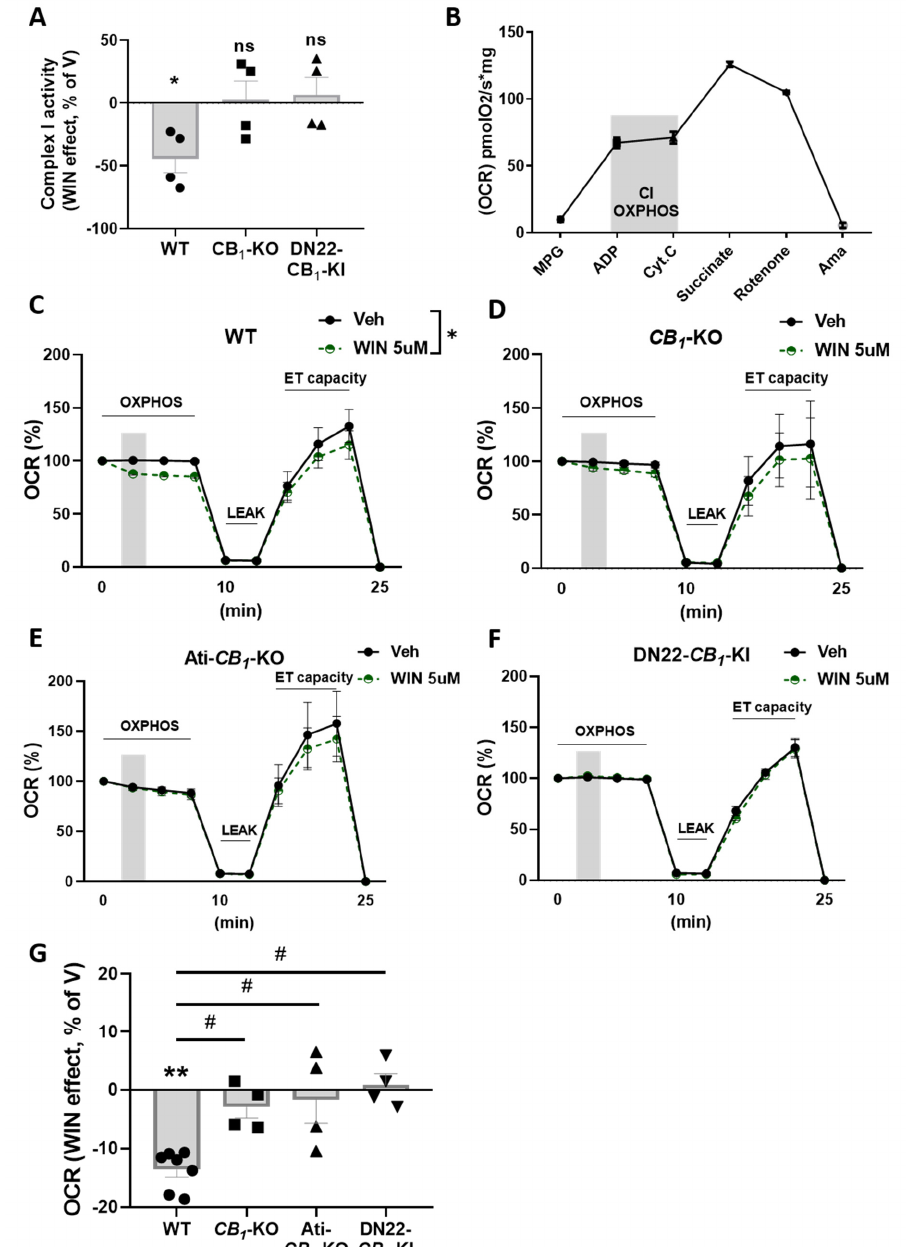
Figure 2. Mitochondrial effects of CB 1 activation in eWAT. ( A ) WIN 5 µ M effect (relative to vehicle, V) on complex I activity in eWAT from WT, CB 1 -KO, and DN22-CB1-KI mice. ( B ) Oxygen consumption rate (OCR) in eWAT homogenates from WT mice. MPG, malate pyruvate glutamate; ADP, adenosine di-phosphate; Cyt.C, cytochrome C; Ama, antimycin A. The gray area indicates complex-I-dependent respiration (OXPHOS) used for testing cannabinoid agonist effects. ( C – F ) Time course of the WIN effect on the oxygen consumption rate (OCR) in eWAT homogenates from WT ( C ), CB 1 -KO ( D ), Ati- CB 1 -KO ( E ), and DN22- CB 1 -KI ( F ) mice. The OXPHOS phase represents complex-I-dependent respiration ( see B ); LEAK, oligomycin-dependent ATP synthase inhibition; ETS, electron-transfer- system in an uncoupled state (by the addition of carbonyl cyanide m-chlorophenylhydrazone). The grey area indicates WIN (or vehicle) administration. ( G ) The WIN effect (relative to vehicle, V) on complex-I-dependent OXPHOS respiration in eWAT homogenates from WT, CB 1 -KO, Ati- CB 1 -KO, and DN22- CB 1 -KI mice calculated from panels ( C – F ), respectively. * p < 0.05; ** p < 0.01 from vehicle. # p < 0.05 from